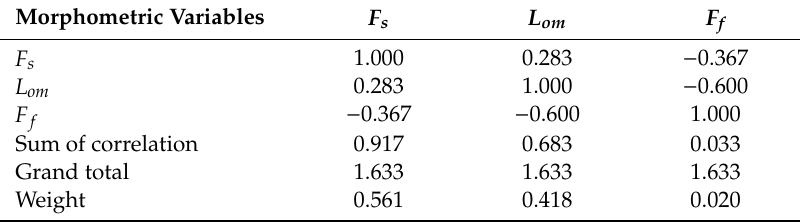
Table 11. Cross-correlation matrix of F s , L om and F f variables of nine sub-watersheds of